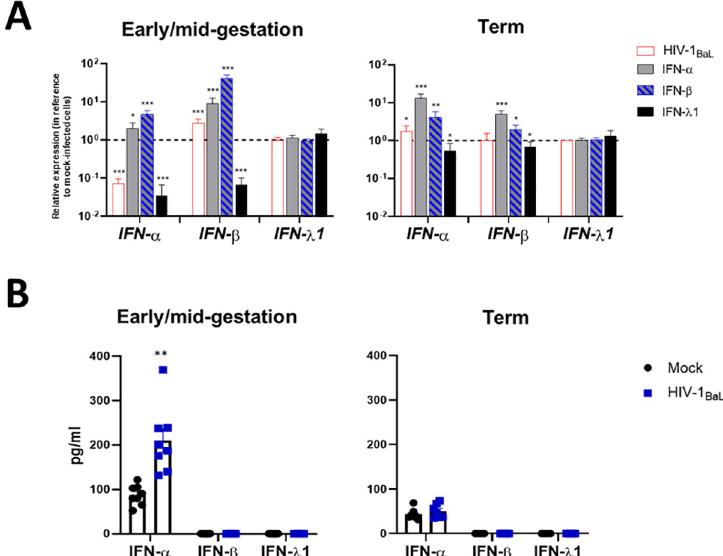
Fig 5. HIV Induces Type I IFN Production in Early/Mid-Gestation HCs. Hofbauer cells (isolated from early/mid- gestation and term) were infected with HIV-1 BaL and treated with IFN- α (100 IU/mL), IFN- β (100 ng/mL), IFN- λ